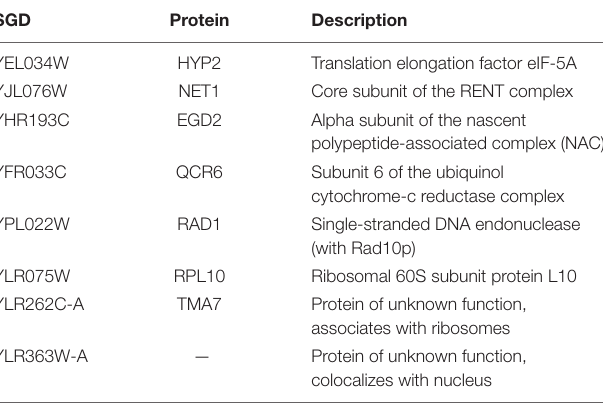
TABLE 1 | A list of proteins identified using chemical proteomics experiments with probe P6. SGD